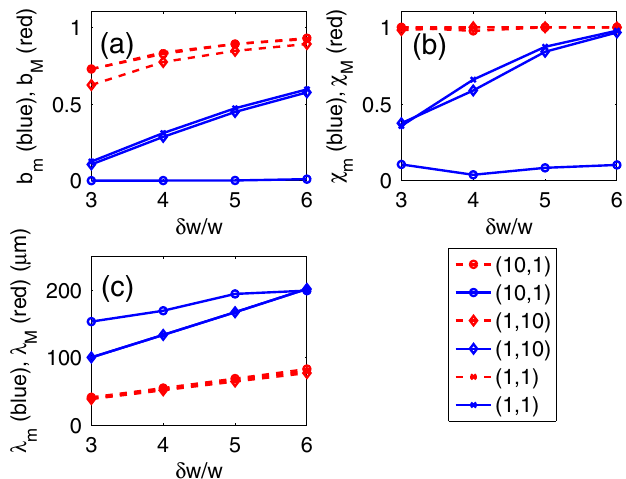
FIG. 6. Bunching factor (a), contrast ratio (b), and modulation wavelength (c) obtained for a longitudinally modulated beam produced via interception with thick mask upstream of the EEX beam line. The slit width is w ¼ 100 (cid:14) m and the slit separation (cid:2)w is variable. The parameters with subscript m (and shown as blue traces) are computed using the longitudinal beam distribu- tion downstream of the EEX beam line while the parameters with subscript M (and shown as red traces) are obtained after the removal of the chirp associated to the beamlet (in this latter case, the beamlets are made upright). The parameters are calculated for various initial normalized emittance partitions ð " n shown in the legend. The beam Lorentz factor for these simu- lations is (cid:9) ¼ 30 ratio (cid:16) . When the final horizontal and longitudinal M